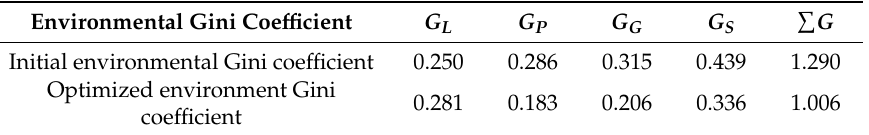
Table 10. Optimization results of environmental Gini coe ffi